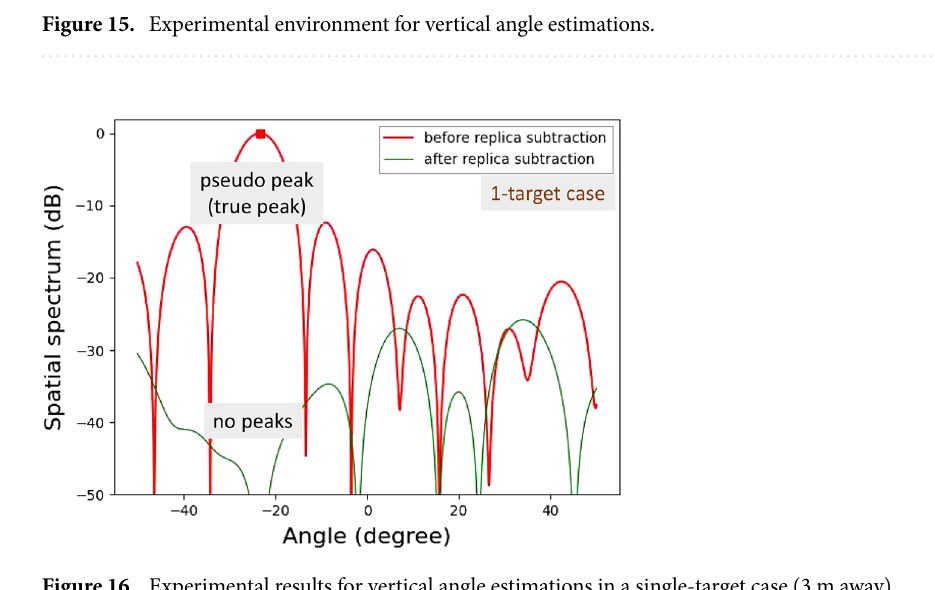
Figure 16. Experimental results for vertical angle estimations in a single-target case (3 m